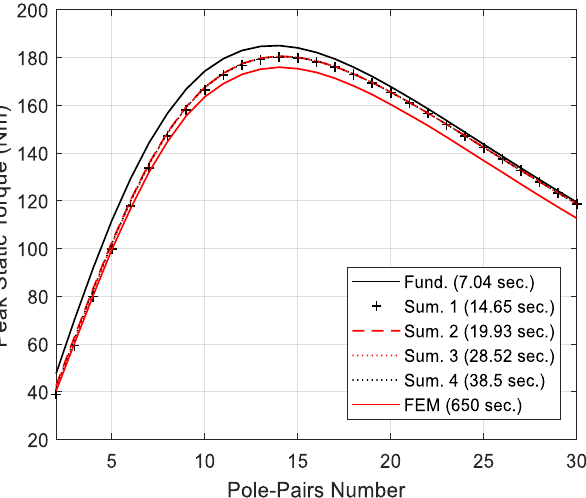
Figure 14. Case seven: Comparison of the peak static torque as function of the pole-pairs number.